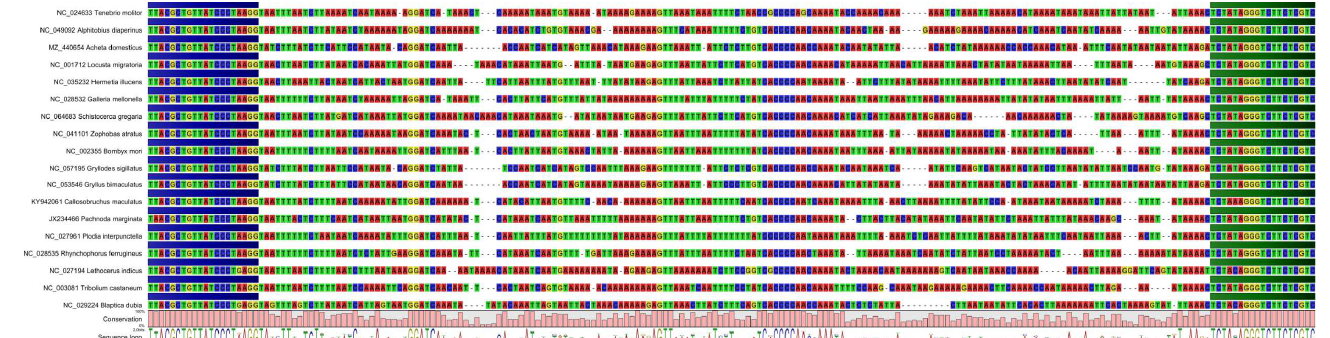
Figure 1. Multi-species sequence alignment of the mitochondrial 16S rDNA barcoding region of edible and relevant insects in Europe. The universal primer set binding sites are highlighted by blue (forward primer) and green (reverse primer) colored bars (CLC Genomics Workbench 11, Qiagen, Hilden, Germany).